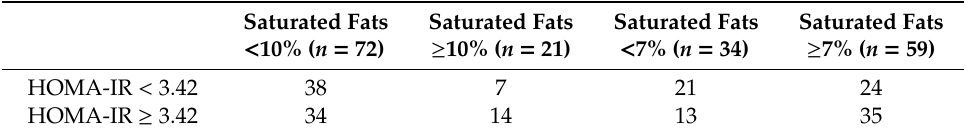
Table 8. Association of normal HOMA-IR and saturated fats intake < 10% of total energy (E, χ 2 2.461, p = 0.117) or < 7% E ( χ 2 3.840, p =